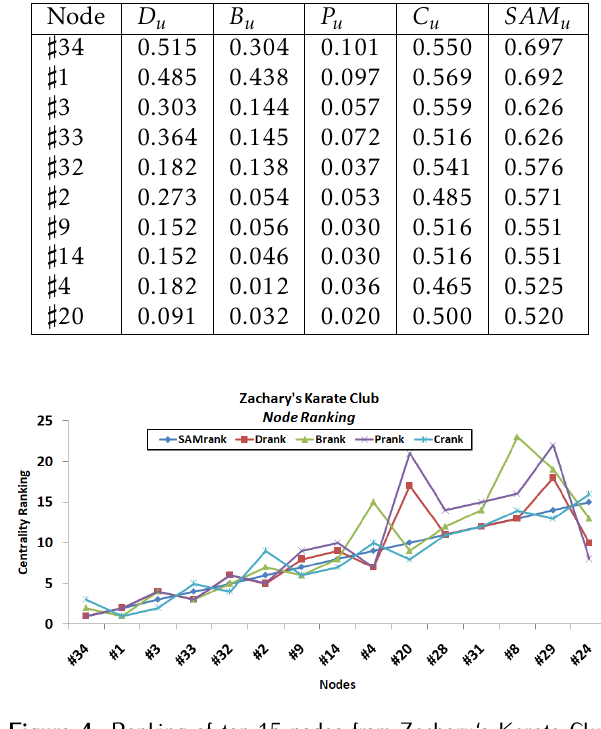
4.2. Dataset 2: Dolphin Dolphin is an undirected social network of frequent interaction between 62 dolphins in New Zealand.